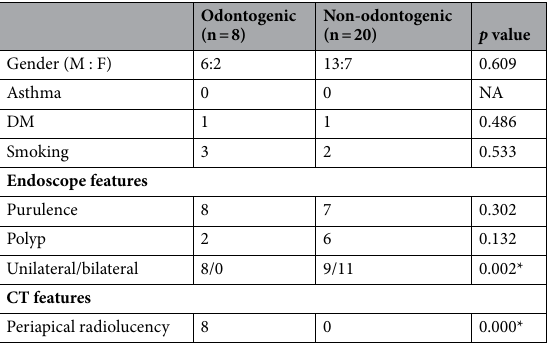
Table 1. Demographics of patients. DM diabetes mellitus, CT computed tomography. * p < 0.05.